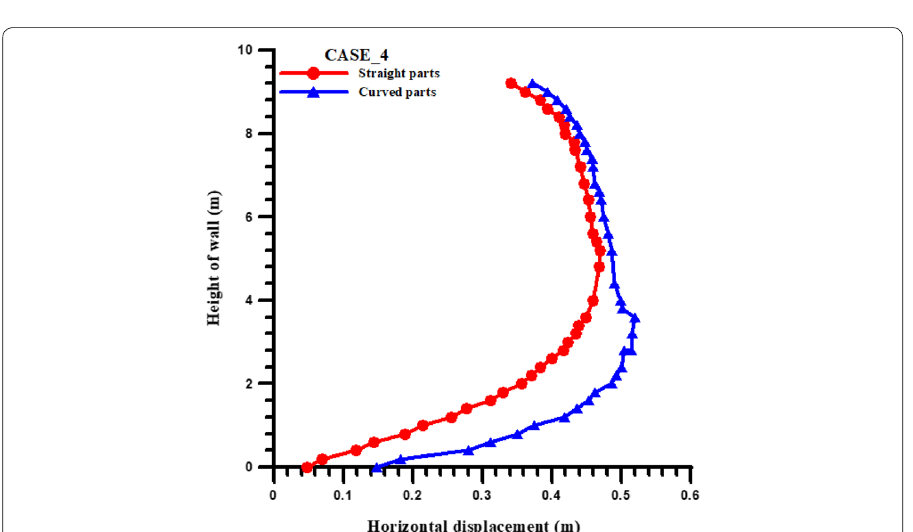
Fig. 14 Horizontal displacement comparison of straight and curved parts for Case